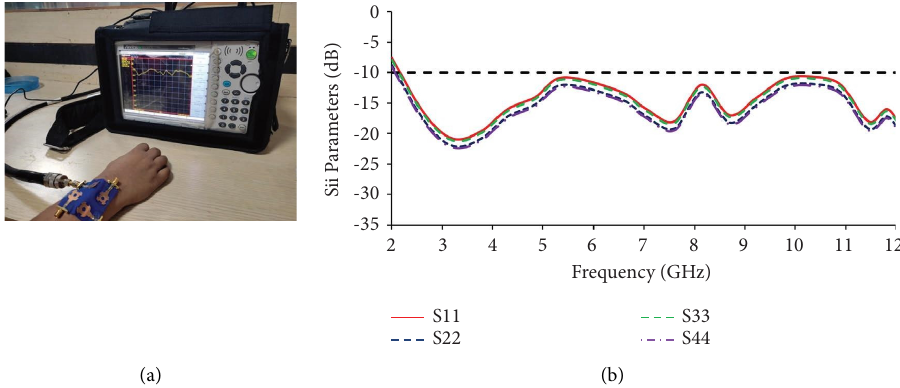
Figure 22: SAR analysis of the antenna prototype (measured): (a) on-body and (b) refection